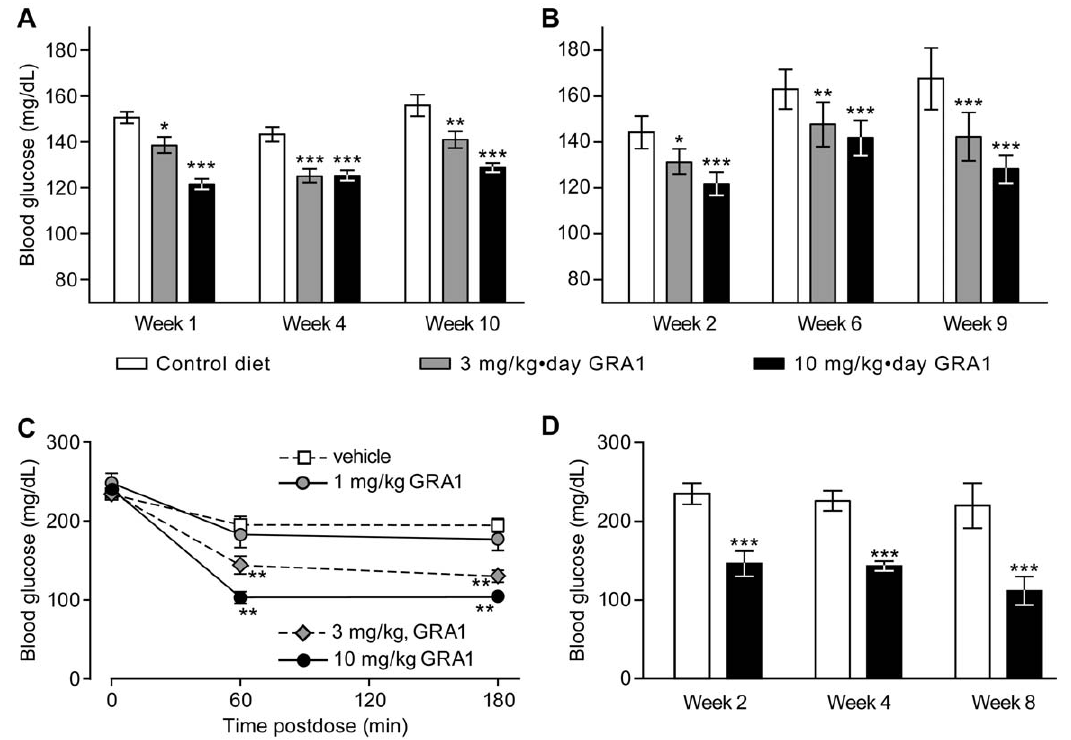
Figure 4. GRA1 lowers blood glucose in the DIO hGCGR and hGCGR.ob/ob mouse. Mean ( 6 SEM) blood glucose concentrations in (A) non- fasted and (B) fasted DIO hGCGR mice treated with approximately 3 and 10 mg/kg ? day GRA1 provided as a food admixture. (Additional data from this study are in Table 2). (C) Mean ( 6 SEM) blood glucose concentrations in the hGCGR.ob/ob mouse following single oral doses of 1, 3, or 10 mg/kg GRA1 or vehicle. (D) Mean ( 6 SEM) non-fasted blood glucose concentrations in hGCGR.ob/ob mice treated for 2–8 weeks with control diet or 10 mg/ kg ? day GRA1 administered as diet admixture. *p , 0.05, **p , 0.01, and ***p , 0.001 in timepoint-matched comparisons with controls; n=8 in each group.